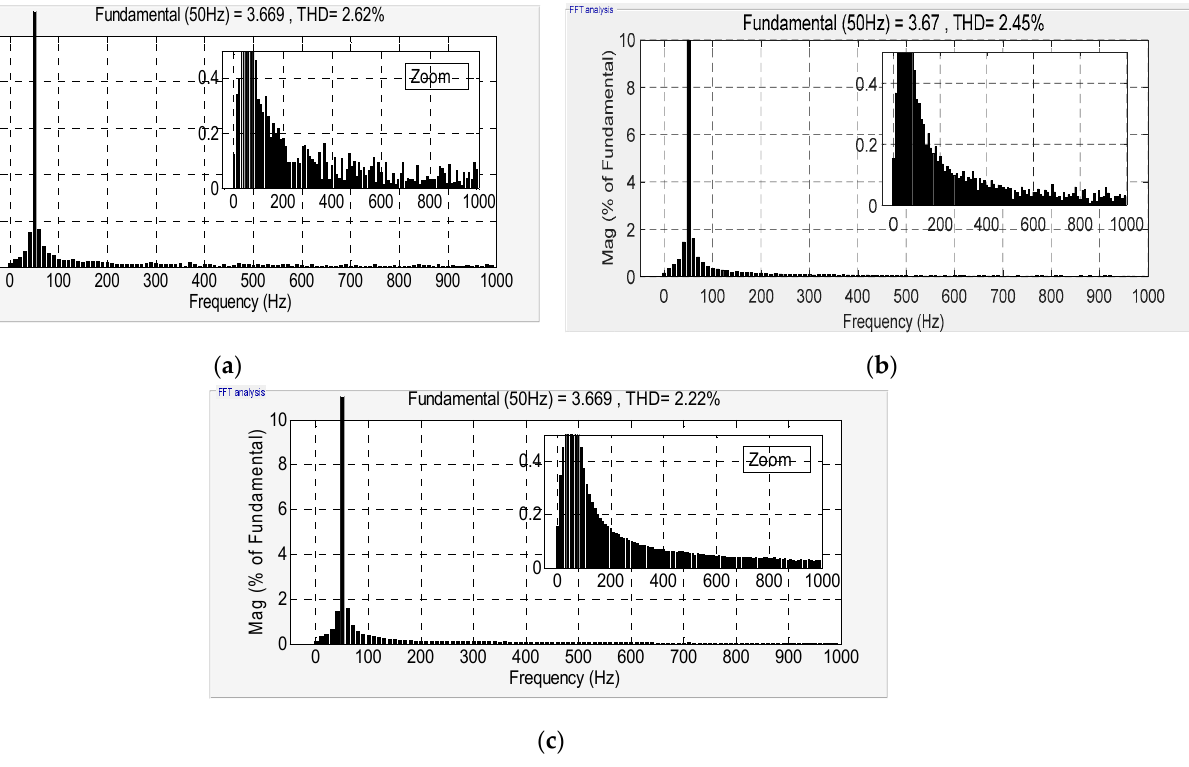
Figure 21. THD for the stator current i sa : ( a ) DPC, ( b ) Backstepping control, ( c )DPC ‐ ANN. The comparison between the three controllers is presented in Table 4. This table shows remarkable improvements obtained by the intelligent DPC strategy (DPC ‐ ANN) in term of optimization of the dynamics response, rise time, reduction in ripples, and the minimization in the harmonics in the current.